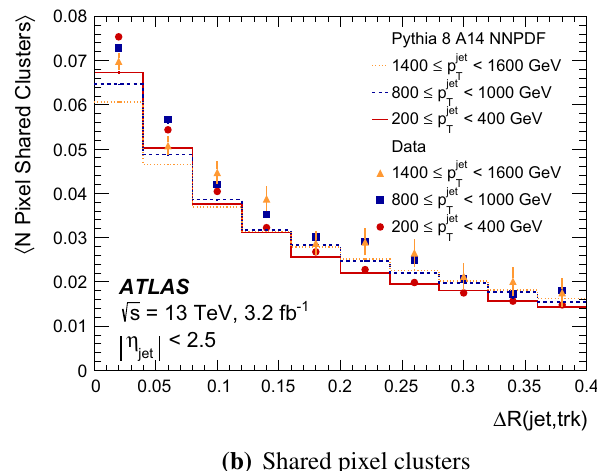
Fig. 5 The average number of a pixel clusters identified as merged and b shared pixel clusters on primary tracks (with a production vertex before the IBL) are shown as a function of the angular distance of the track from the jet axis. Data (markers) and dijet MC (lines) samples